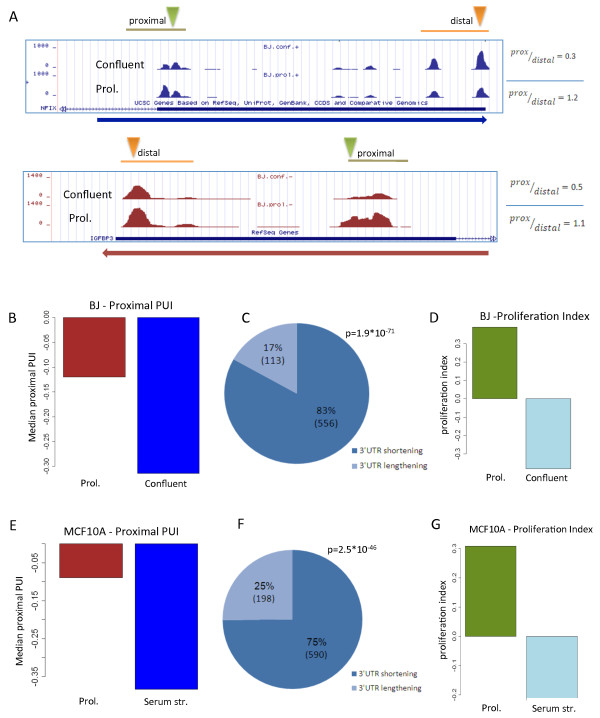
Extensive 3' UTR shortening in proliferative cells. (a) Two examples of transcripts that showed enhanced usage of proximal CSs in BJ proliferating cells compared to confluent ones. The blue and red plots correspond to genes encoded on the positive and reverse strands, respectively. Proximal and distal CSs are indicated by green and orange triangles, respectively. Ratios between proximal and distal peak levels are indicated to the right. (b) The proximal polyadenylation site usage index (proximal PUI) provides a global measure for the relative usage of proximal CSs in the examined conditions (Materials and methods). The transition from proliferation to confluent state resulted in a strong decrease in the proximal PUI. (c) A pie chart showing the distribution of transcripts that underwent significant change in CS usage in the transition from proliferation to confluent. In dark and light blue are the proportions of transcripts with shortened or lengthened 3' UTRs in the proliferative state, respectively. (d) The proliferative status of proliferating and confluent BJ cells was measured using a proliferation index, which is based on the relative expression of cell-cycle related genes. (e-g) Same as (b-d), but here proliferating and serum-deprived MCF10A cells were analyzed.